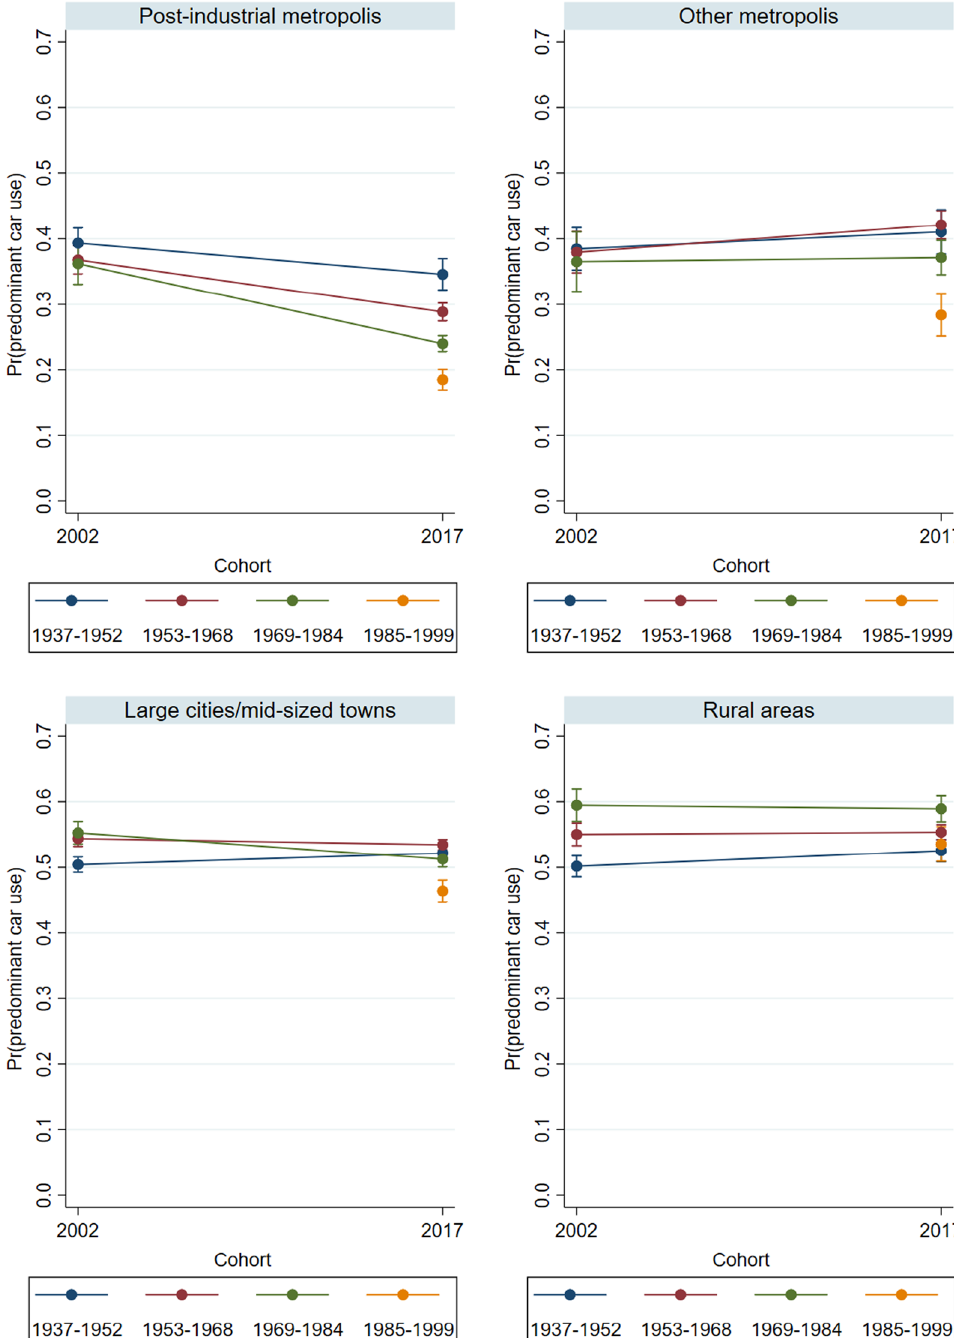
Fig. 5 Predicted probabilities of predominant regular car use in 2002 and 2017 – by settlement type (Model 2). Source: Mobility in Germany: MiD person-time-series dataset (own calculations). Note : Predominant car use is defined as (almost) daily car use and bicycle use of at most 1 to 3 times per week. Survey weights are applied. See also Table 4 for main effects and standard